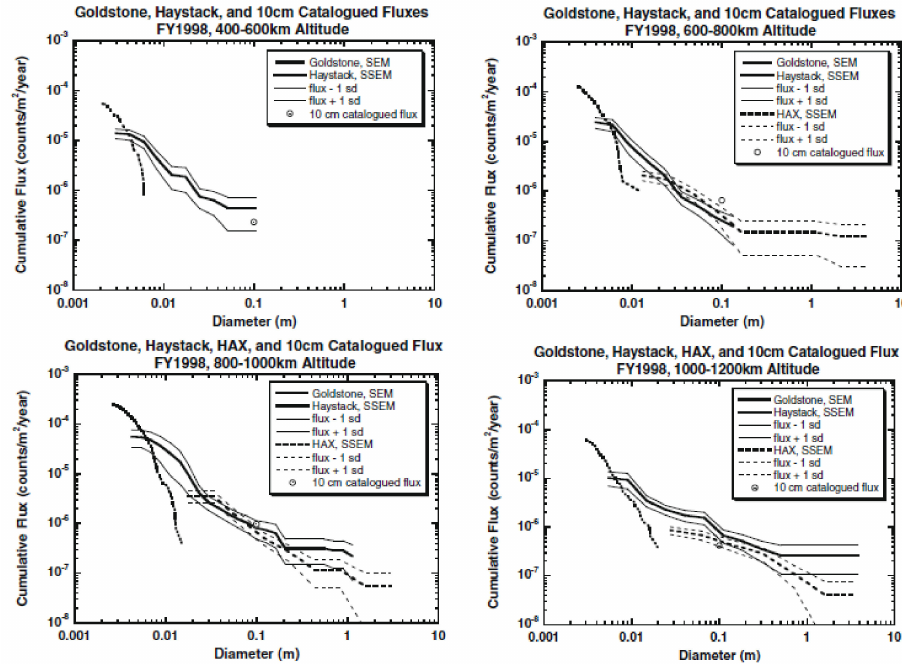
Figure 8. Debris flux versus diameter at different altitudes for the Goldstone, Haystack, HAX radars during fiscal year 1998 [22]. Reprinted from Advances in Space Research, Copyright 2009, with permission from Elsevier.